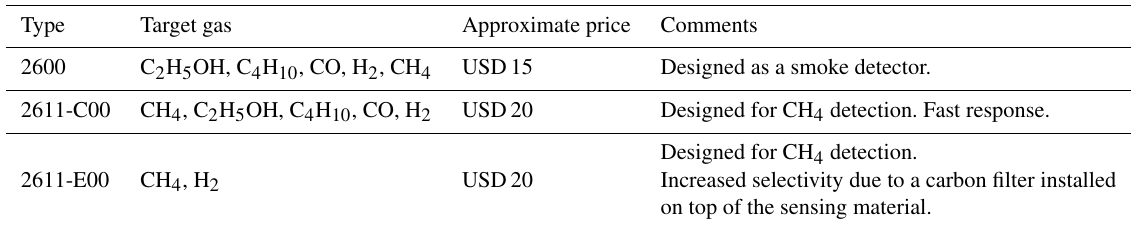
Table A7. Comparison between TGS sensors included in the low-cost logging